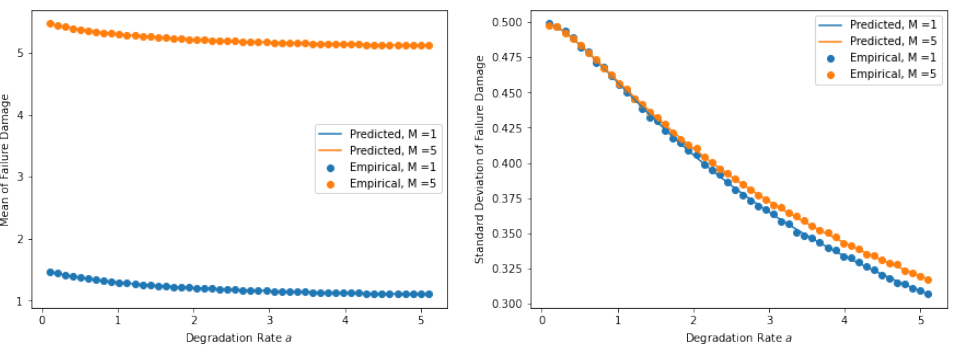
Figure 4. Predicted and empirical values for the mean and standard deviation of the failure